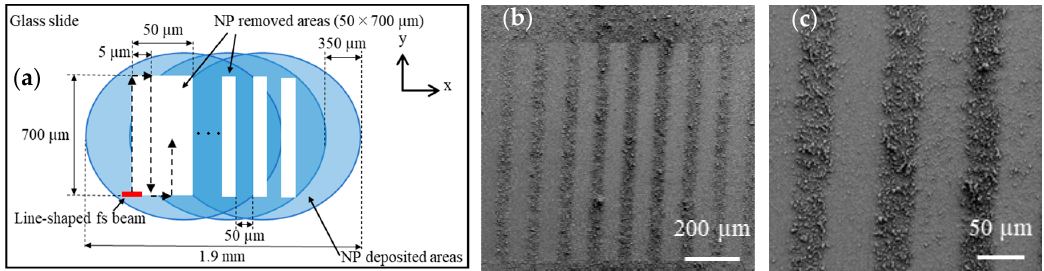
Figure 8. ( a ) Schematic of the CYTOP NP deposition and removal procedures using holographic fs laser processing on a glass slide. A line-shaped fs laser beam was scanned on the NP-deposited areas to divide the glass and NP-network structures (note that the scales do not relatively agree with each other). SEM images showing ( b ) an overall view of the fabricated glass slide and ( c ) an enlarged view of the boundaries between the glass and the deposited network structures.